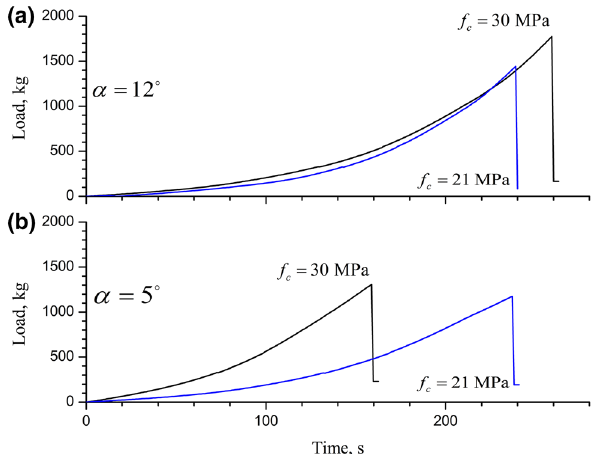
Fig. 2 The load vs time for CUP loading geometry when the specimen compression strength change from 21 to 30 MPa and the contact angle change from 12 ° (Fig. 2a) to 5 ° (Fig. 2b) and: D = 100 nm, as = 3/8 inch, t = 20